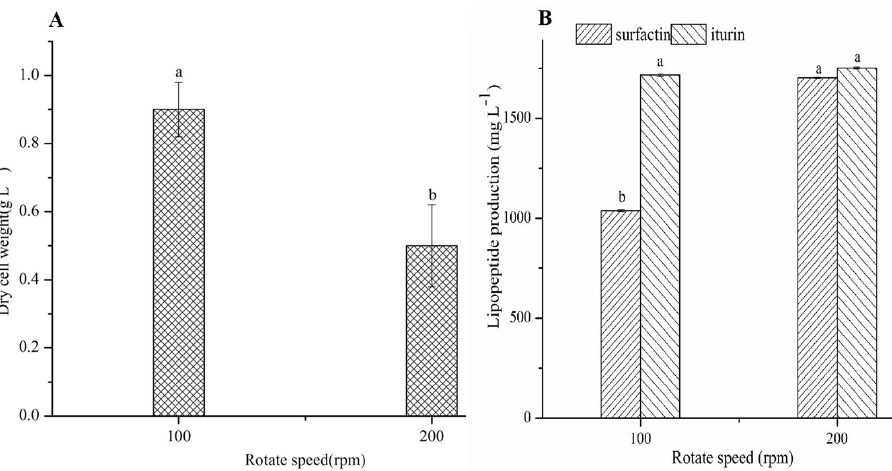
Figure 1. Biomass ( A ) and lipopeptide production ( B ) of B. velezensis CMT-6. a, b represents the difference between different treatment groups. The same letter represents no significant difference, while different letters represent significant difference.